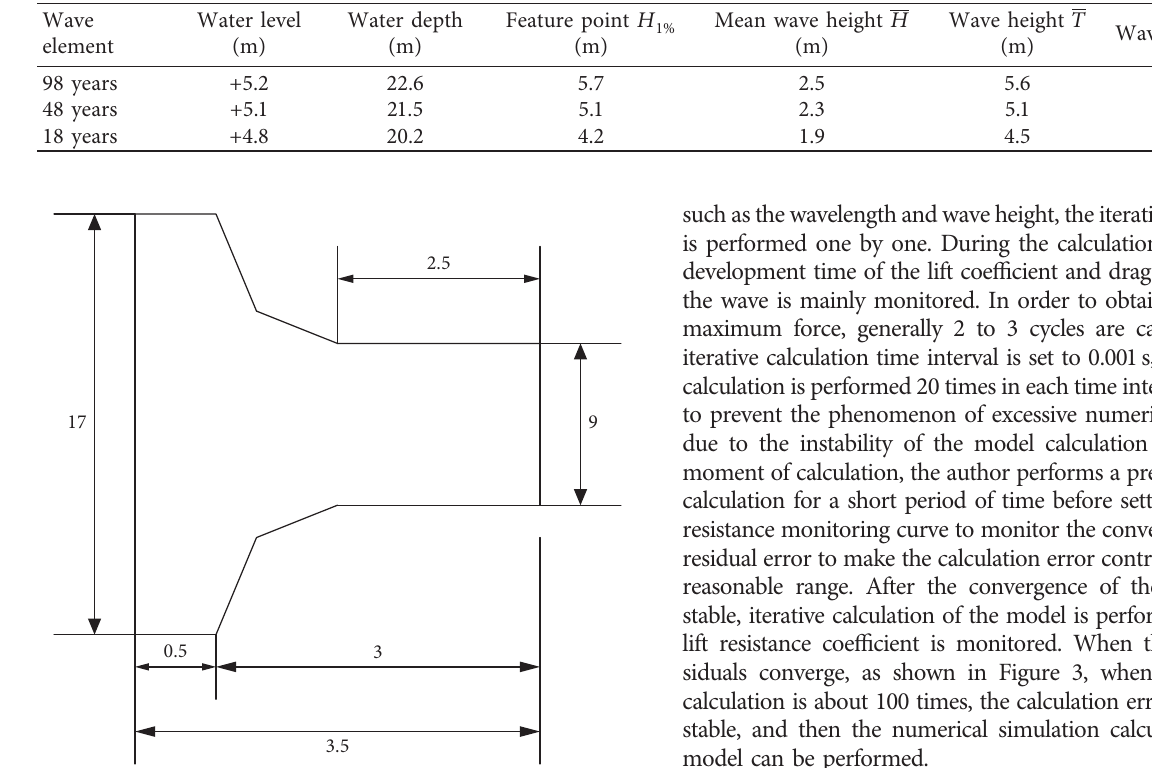
Table 1: Table of design wave elements.